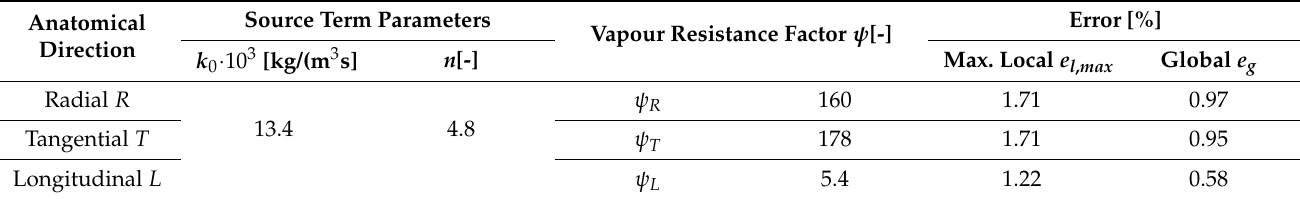
Table 7. Model coefficients and fitting errors for ash.